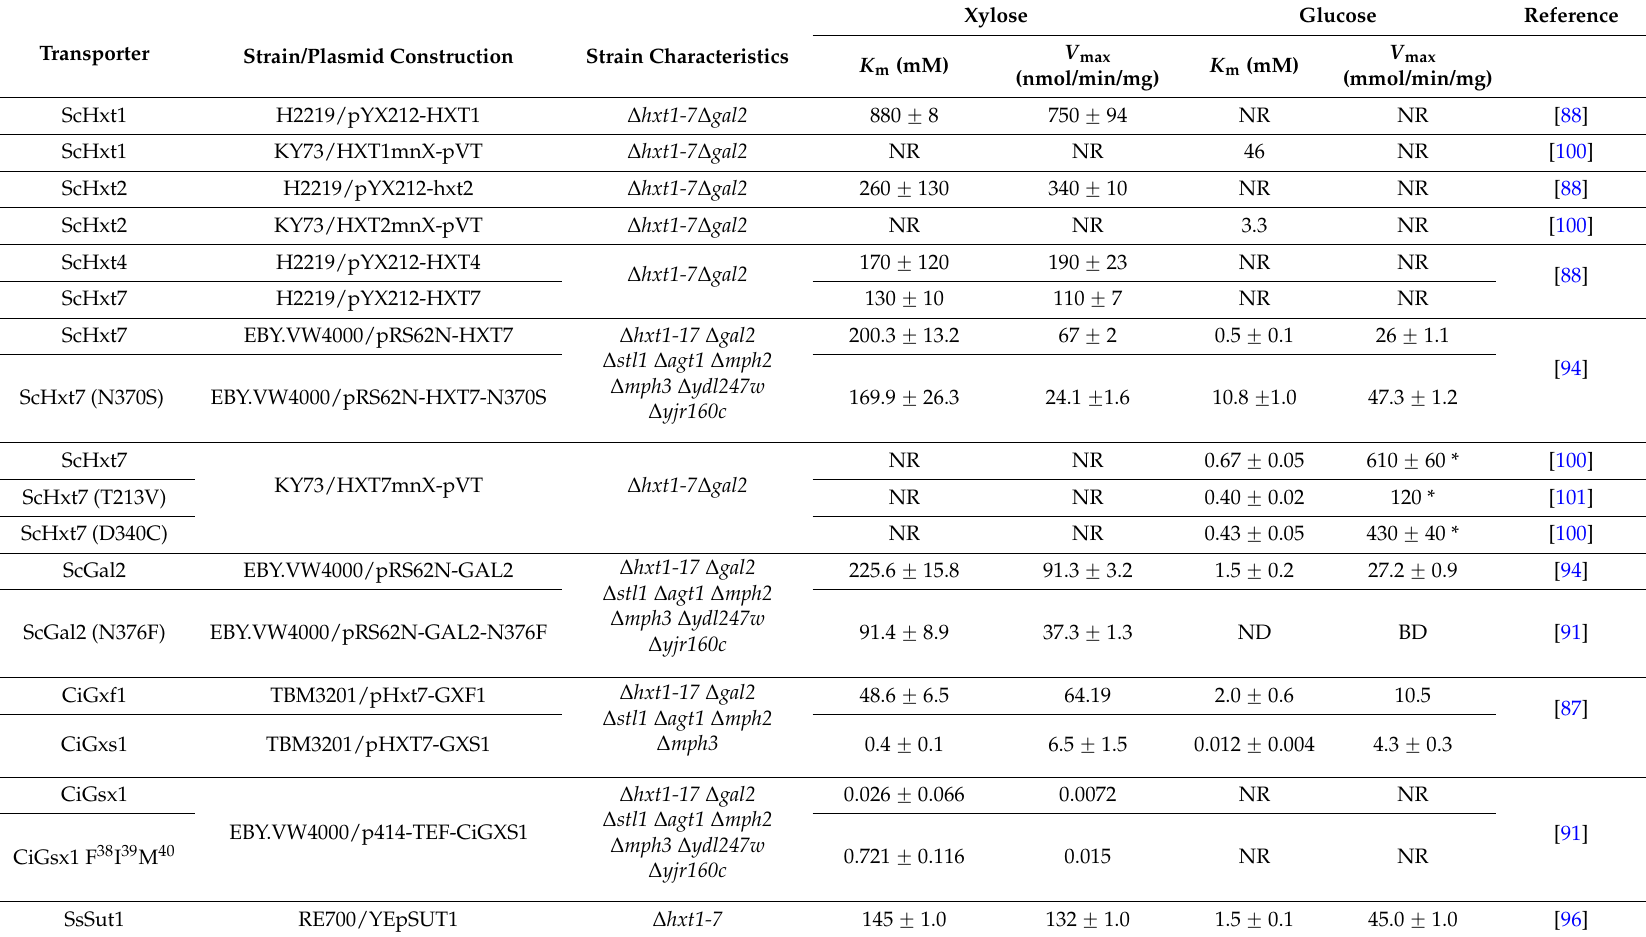
Table 1. Kinetic parameters of yeast glucose/xylose